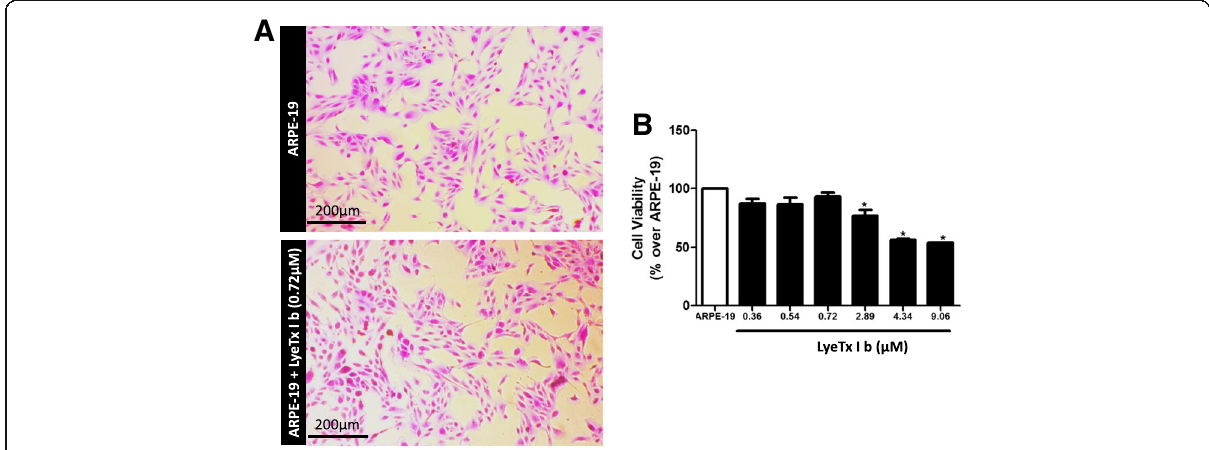
Fig. 1 LyeTx I b does not alter the morphology of ARPE-19 cells and maintains cell viability above 50%. a Figure shows ARPE-19 cells in the absence or presence of LyeTx I b (2.89 μ M) indicating a healthy culture. b Graph shows cells not exposed (ARPE-19) or exposed to LyeTx I b (0.36, 0.54, 0.72, 2.89, 4.34 or 9.06 μ M). Data represent the means ± SEM of three independent experiments. * indicates significant difference as compared to ARPE-19 ( p <0.05). Abbreviations: SEM, standard error of the mean. Cells were visualized (5X) using a Zeiss microscope (Axio Imager M2, Zeiss) and images were captured with a digital camera coupled to